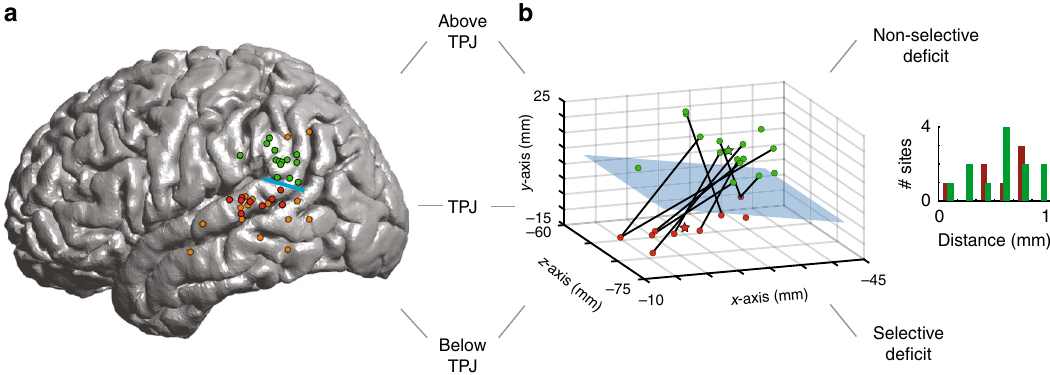
Fig. 3 Partitioning of linguistic function within individual subjects. a Sites in which stimulation elicited a signi fi cant and selective de fi cit in the syntactic condition are displayed in red, whereas sites in which stimulation elicited a non-selective language de fi cit that involved more than one condition are displayed in green. Sites in which stimulation elicited a de fi cit but which did not reach the signi fi cance threshold (e.g., stimulation of the site elicited a de fi cit that was not reproducible on subsequent trials) are displayed in orange. b Stimulation sites are evaluated within individual subjects. Here, the anatomic locations of the stimulation sites and their relation to the TPJ plane are displayed in MNI space. The lines are used to indicate which sites were stimulated within the same subject. The bar graph in the inset represents the distance between the stimulation sites and the TPJ